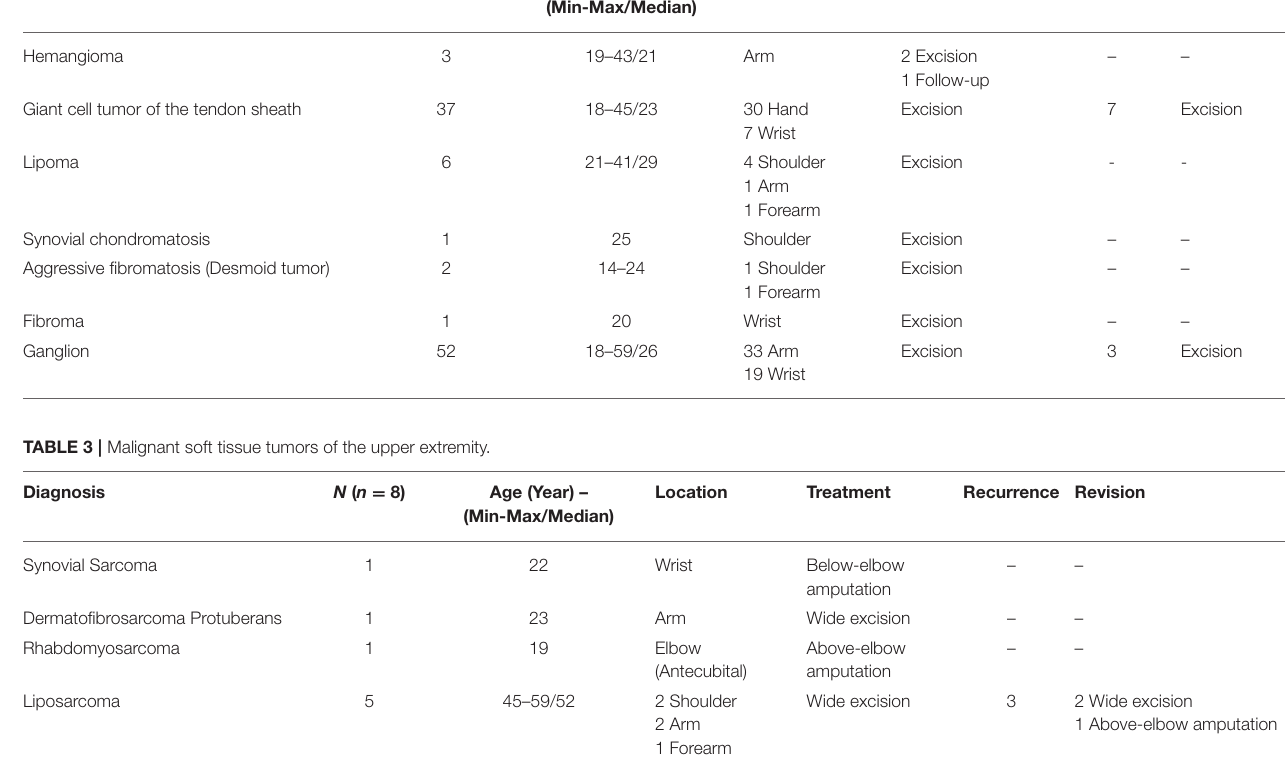
TABLE 2 | Benign soft tissue tumors of the upper extremity. Diagnosis N ( n = 102)